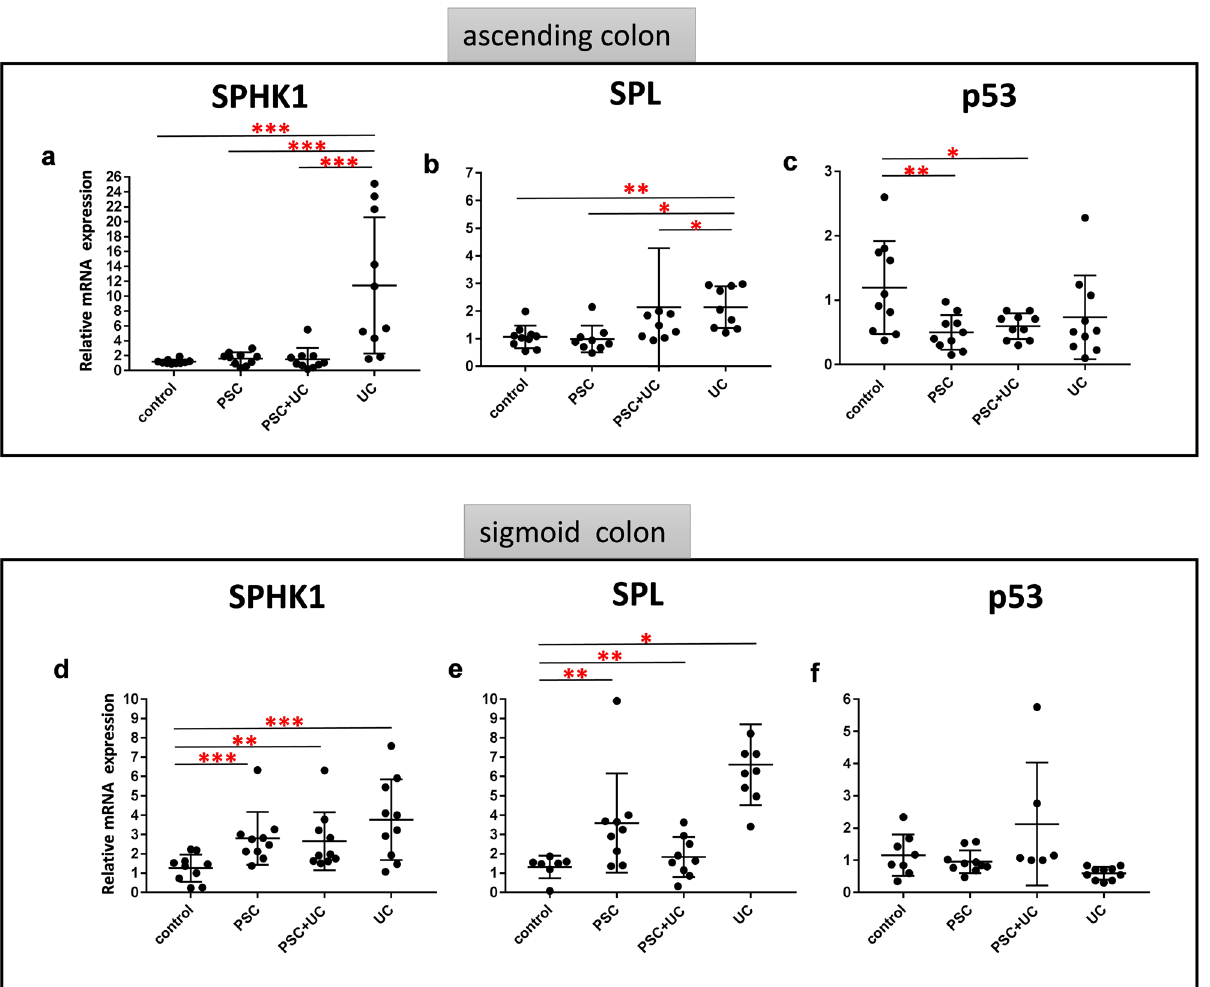
Figure 3. Expression of genes involved in metabolism of sphingosine and p53 in large intestines of the patients. Relative expression levels of sphingosine-kinase-1 (SPHK1) (a,d) , sphingosine-1-phosphate lyase (SPL) (b,e) and p53 (c,f) mRNA in ascending (a–c) and sigmoid colons (d–f) of controls (n = 10), PSC (n = 10), PSC + UC (n = 10), and UC (n = 10). The expression of all genes are normalized to an endogenous reference 18S rRNA and presented as a relative fold change to controls according to the comparative Ct method (2 −ΔΔCt ). Dots illustrate each patient and lines the mean plus interquartile range (IQR). Statistics: one-way ANOVA followed by Fisher’s PLSD test within the groups; *indicates p-value < 0.05, ** p-value p < 0.01, *** p-value < 0.001